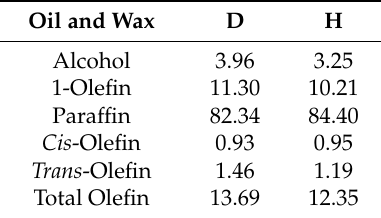
Table 6. The difference in product distribution on a Cobalt/Alumina catalyst when H 2 /CO is switched to D 2 /CO. Reactor Conditions: 220 ◦ C, 19.3 bar, WHSV = 2, and H 2 /CO = 2. Oil and